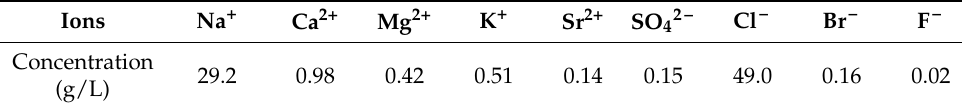
Table 1. Ionic composition of the Halfdan produced water